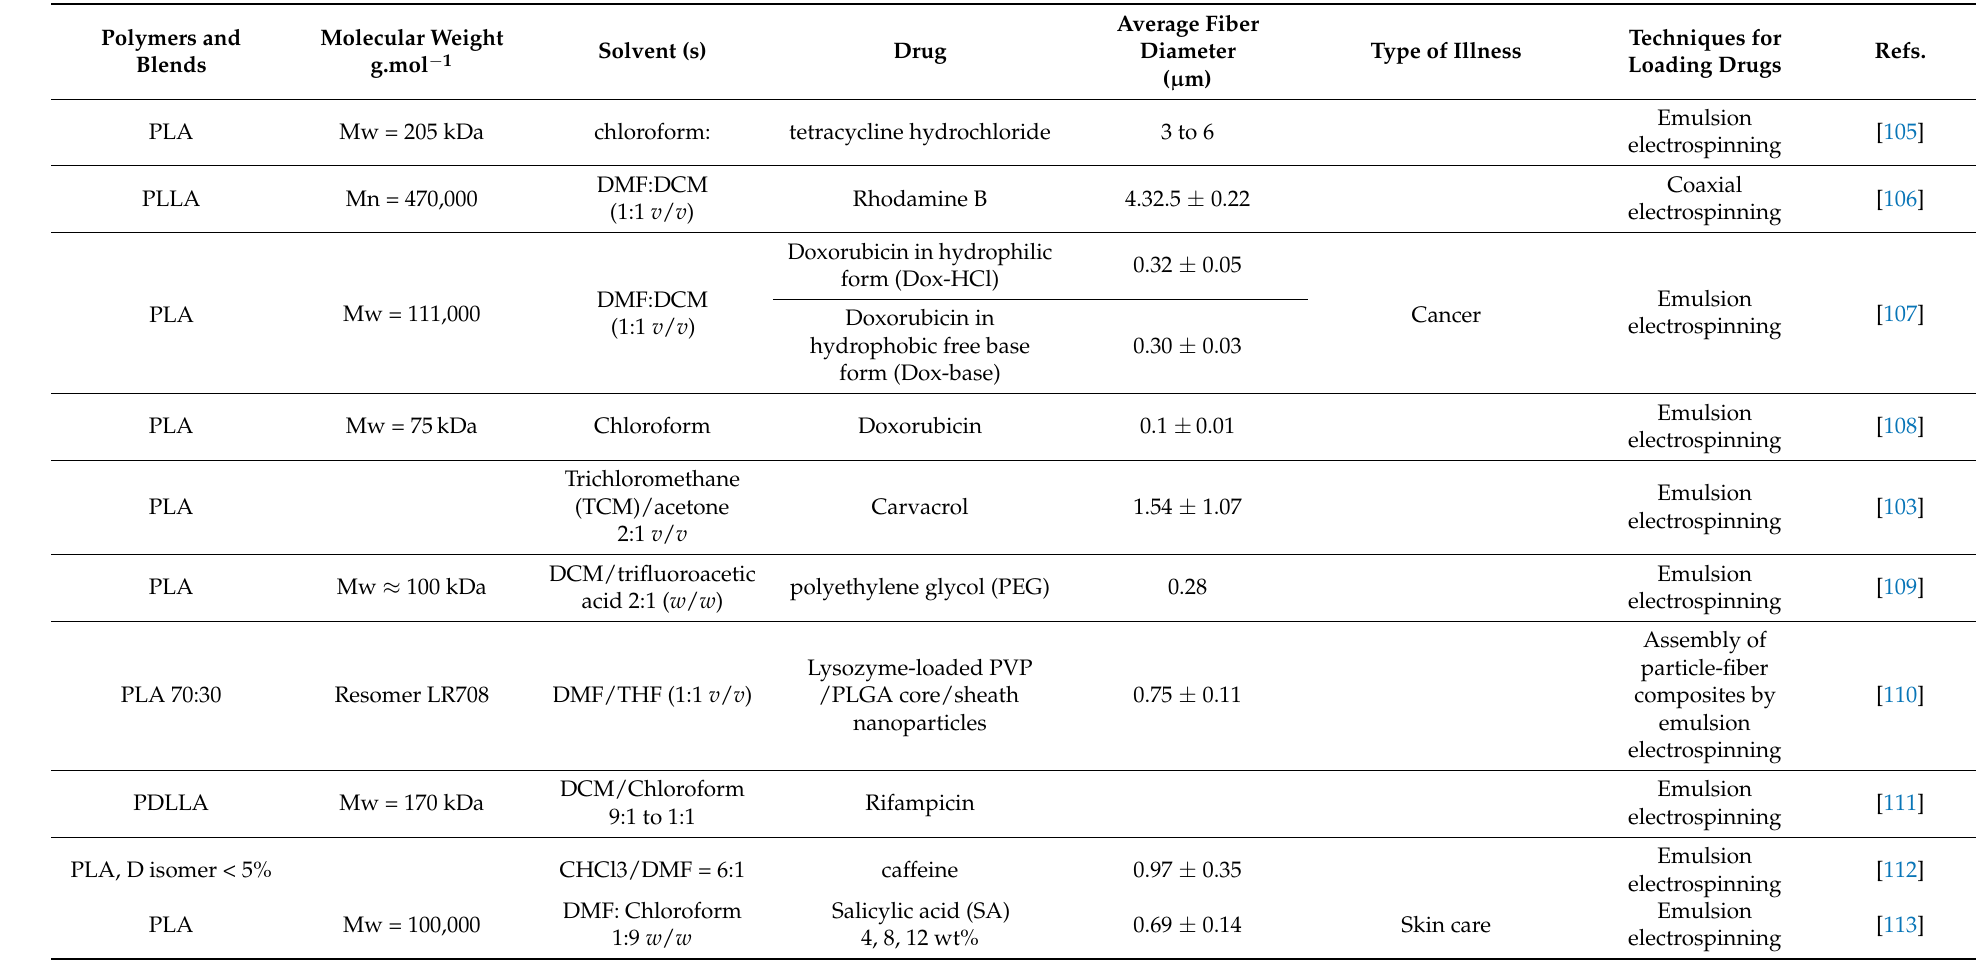
Type of Illness